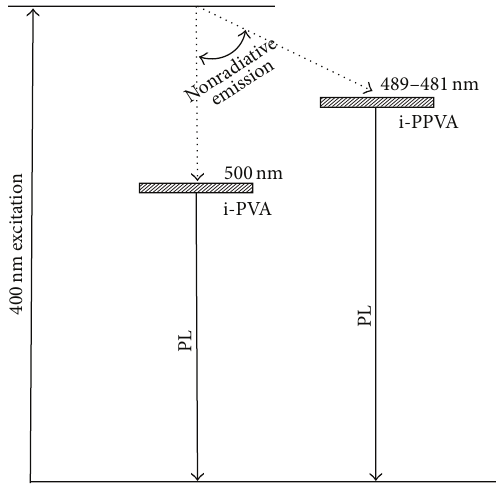
Figure 10: Energy level diagram which shows PL emissions and nonradiative processes occurring simultaneously in i-PVA and i- PPVA polymer molecules at a resonance excitation of 400